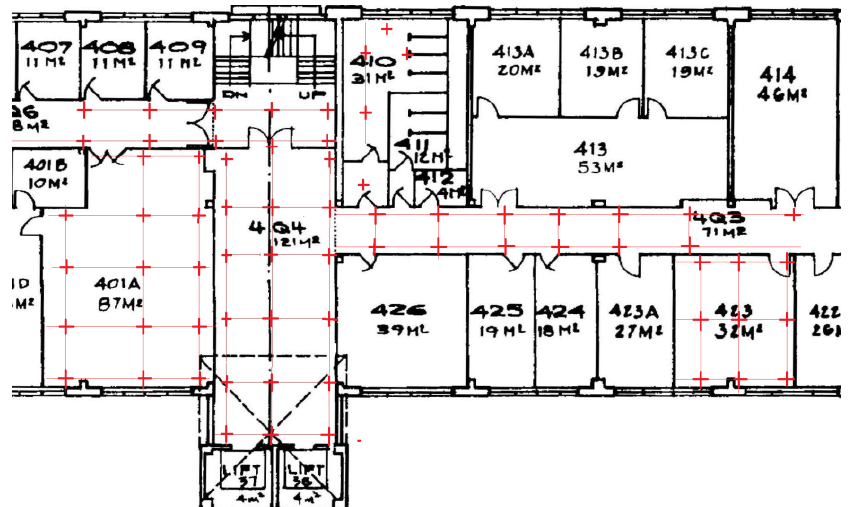
Figure 5. The test bed of the second